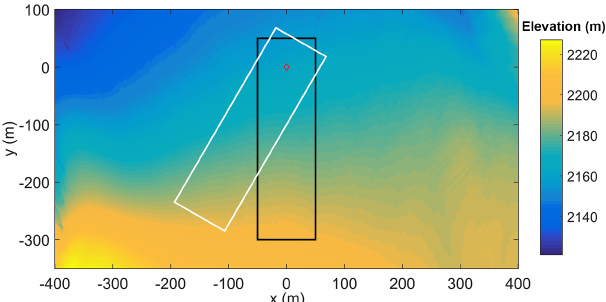
Figure 4. Example of the rotation applied to a DEM patch selected around a station location (red diamond), with the original orienta- tion, outlined in black, and a rotated patch turned 30 ◦ clockwise, outlined in